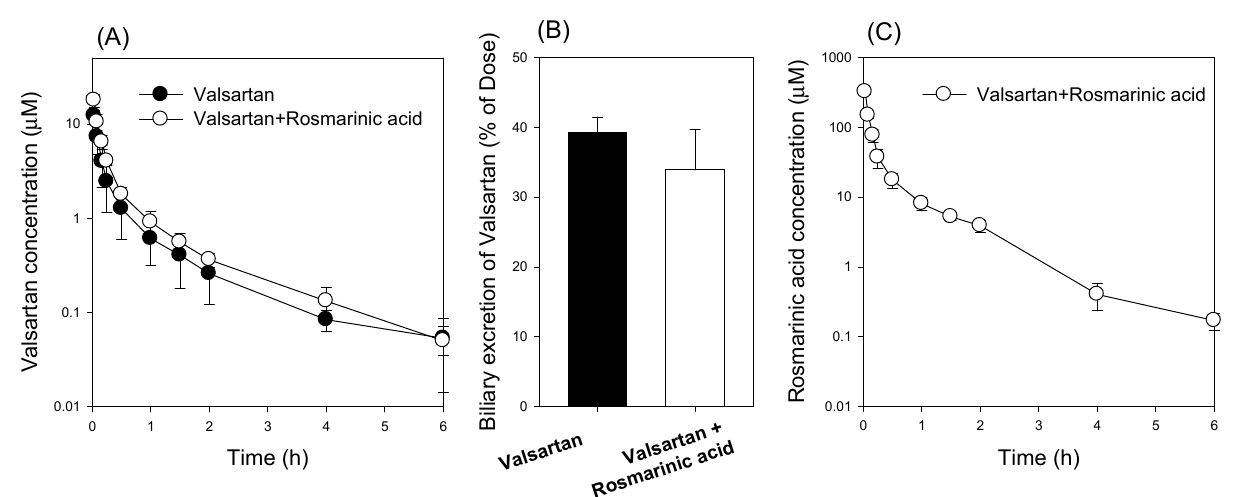
group. Data expressed as mean ± standard deviation ( n = 4).